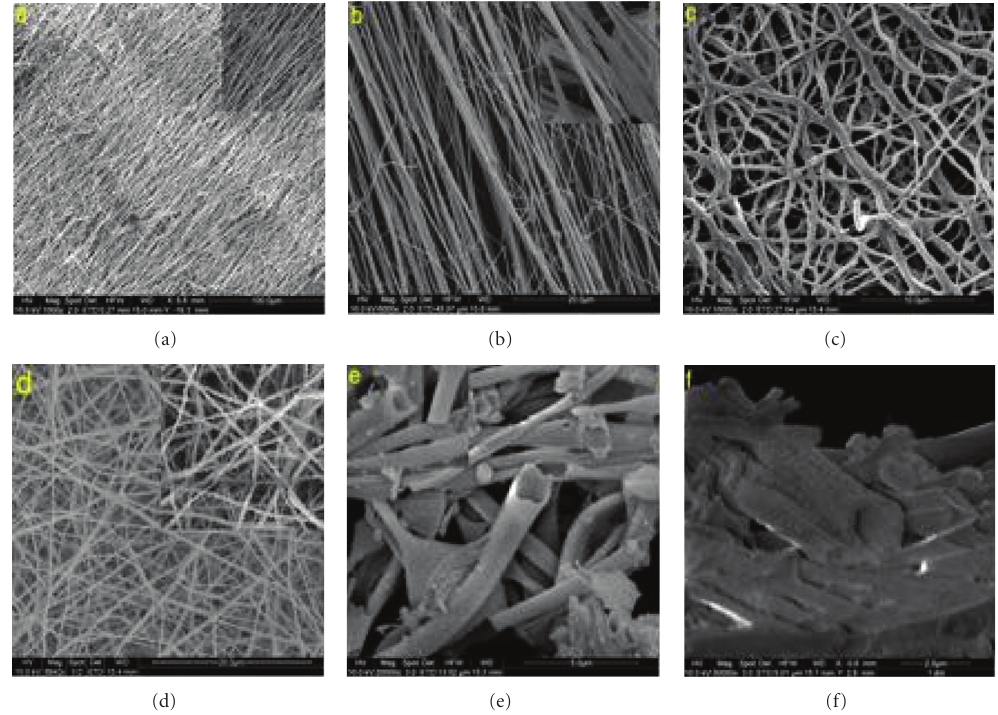
Figure 2: Micrographs showing fiber morphology (a) BTO Aligned Sintered (inset - zoom), (b) STO Aligned Sintered (inset-zoom), (c) BTO Random Sintered, (d) STO Random Sintered (inset-zoom), (e) BTO Hollow (Sonicated) (left inset-fiber), and (f) STO Hollow (Fiber).